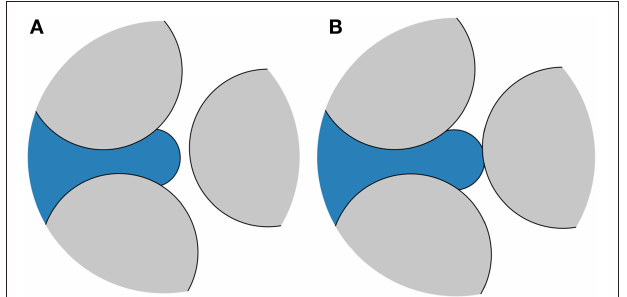
FIGURE 2 | Network node connected to three links. The node point, located near the middle of the pore space, is occupied by non-wetting fluid (blue). (A) The non-wetting fluid extends only a short distance into the links containing wetting fluid (white). The wetting fluid therefore remains connected and may flow freely through the pore space. (B) Non-wetting fluid protrudes far enough into all links to block the pore space for wetting fluid. The wetting fluid must now displace the non-wetting fluid in order to flow